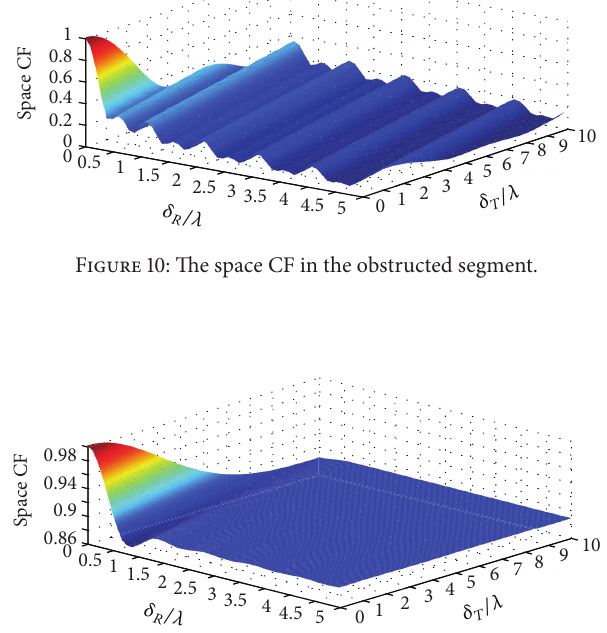
Figure 11: The space CF in the unobstructed segment.